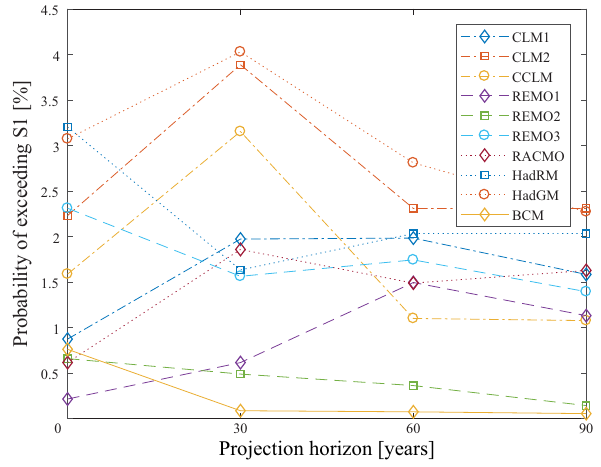
Figure 6. Probability of exceeding in S1 (480m 3 s − 1 ) for the indi- vidual projections at initial planning (year 0) and at later time points (years 30, 60 and 90). Solid symbols mark group 2 of effective pro- jections (see Sect.